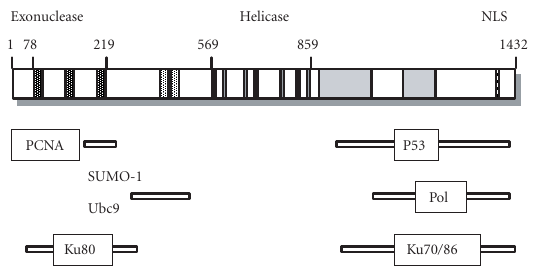
Figure 3. Proteins that interact with the WRN protein. Proteins known to interact with WRNp at specific sites are shown schematically. The approxi- mate regions of protein-protein interaction are